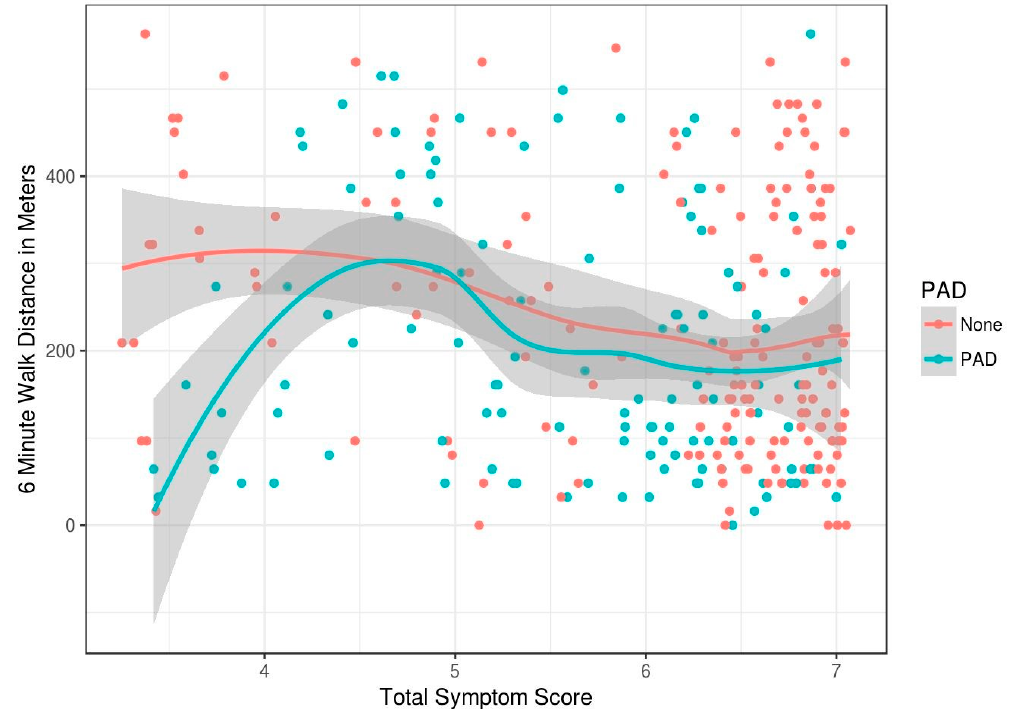
mean (SEM). Each panel represents data from patients with various severities of PAD ranging from CLI in the top left panel to no PAD in the bottom right panel. We used a combination of severity of TBI and calf circumference to categorize PAD severity. Calf circumference of 35 cm is based on an article by Ali et al. [17]. The colored dots represent data from individual patients with the color code exhibiting the severity of claudication in the past 2 weeks with the blue/purple colors representing more severe symptoms.